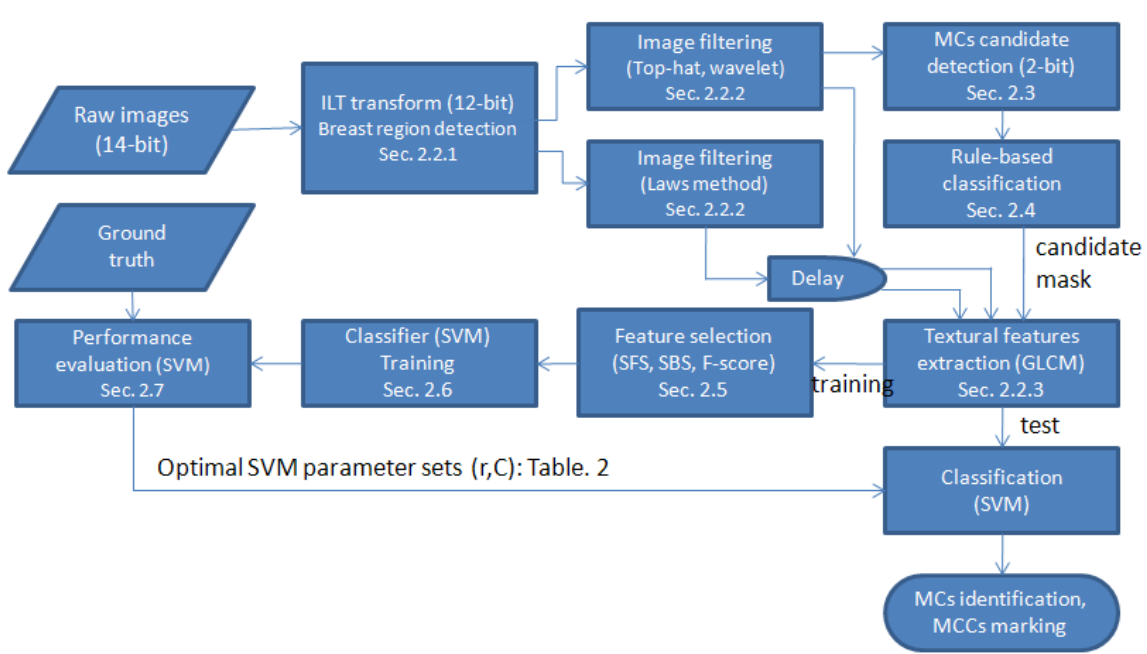
Figure 2. A flowchart of the proposed